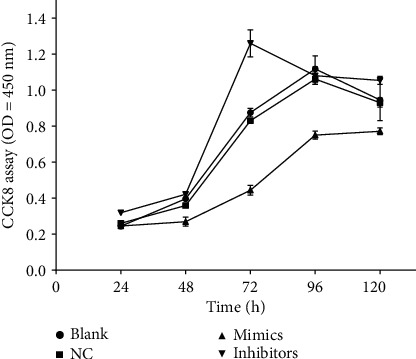
Effects of miR-499a-3p on the proliferation of primary HUVECs. The proliferation of HUVECs was measured by the CCK8 assays every 24 h after transfection of miR-499a-3p (n = 3). The OD450 is in proportion with living cell numbers and is representative of cell proliferation.